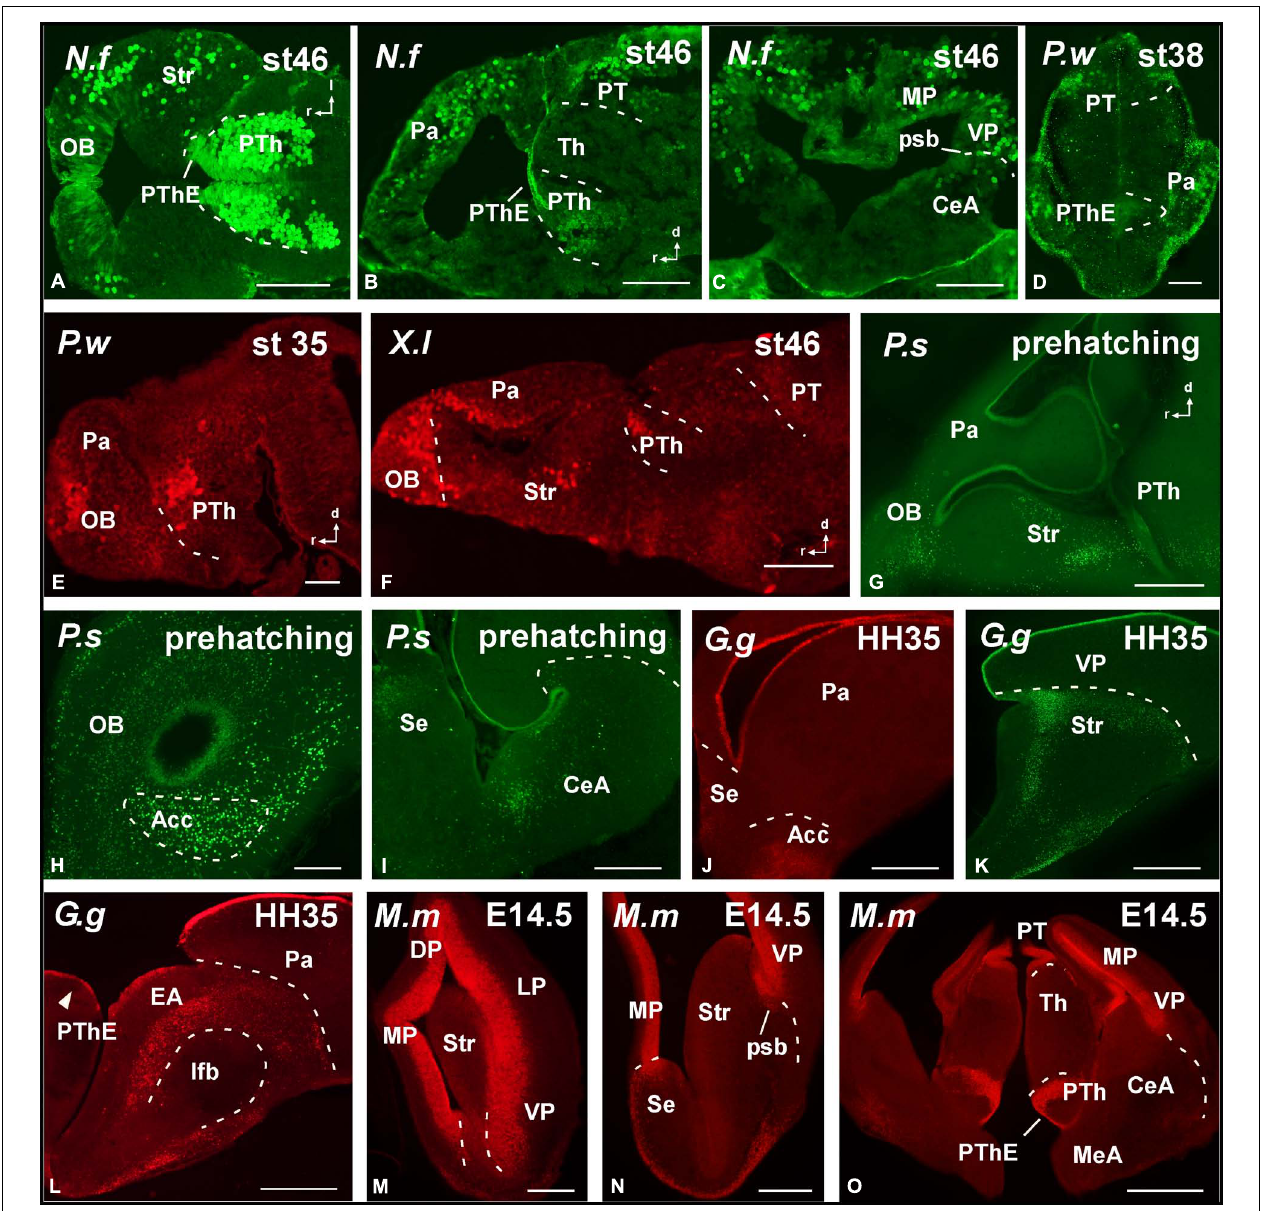
FIGURE 3 | Photomicrographs of horizontal (A), sagittal (B,E–G), and transverse (C,D,H–O) sections at prosencephalic levels that illustrate rostrally the localization of Pax6-immunoreactive cells in the olfactory bulb of Neoceratodus forsteri (A), Pleurodeles waltl (E), Xenopus laevis (F), and Pseudemys scripta (G,H). In the pallial region, the subventricular zone of anamniotes (B–F) and the ventricular zone of amniotes (I–O) show